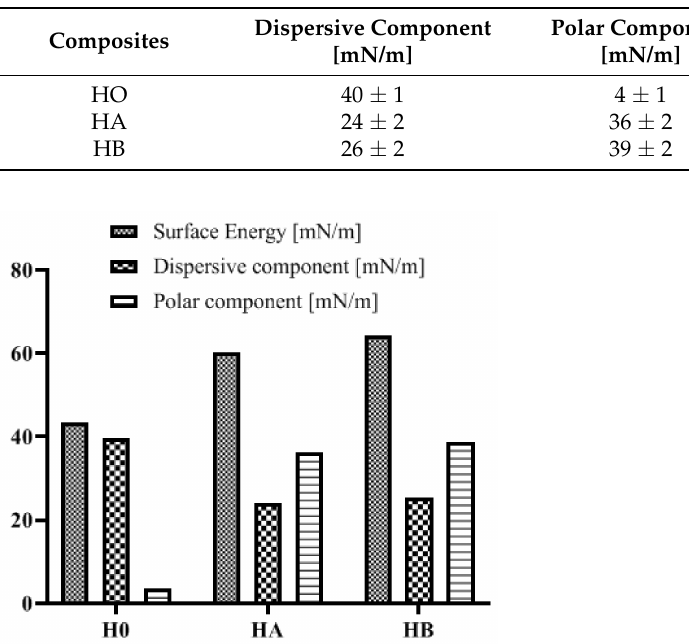
Table 5. Surface energies of the composites.